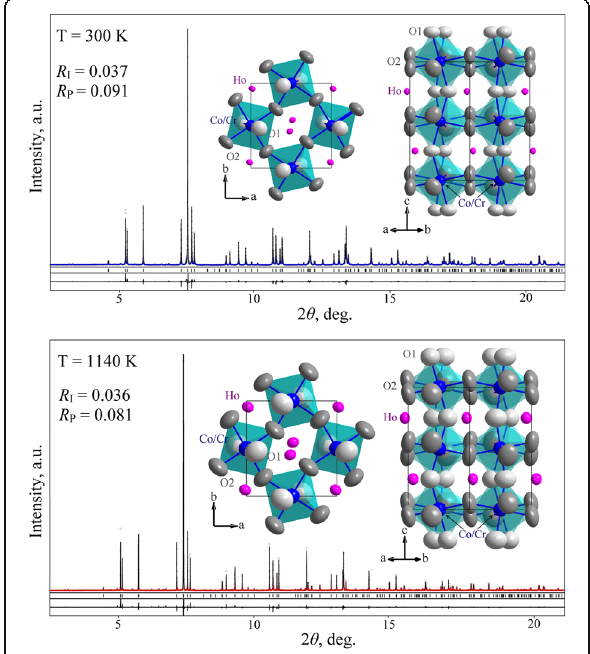
Fig. 2 X-ray synchrotron powder diffraction patterns of HoCo 0.5 Cr 0.5 O 3 at 300 and 1140 K. Experimental ( dots ) and calculated patterns, difference profiles and positions of the diffraction maxima are given. Insets show corresponding structures in projections on (001) and (110) planes. The displacement ellipsoids of atoms are shown at 90% probability